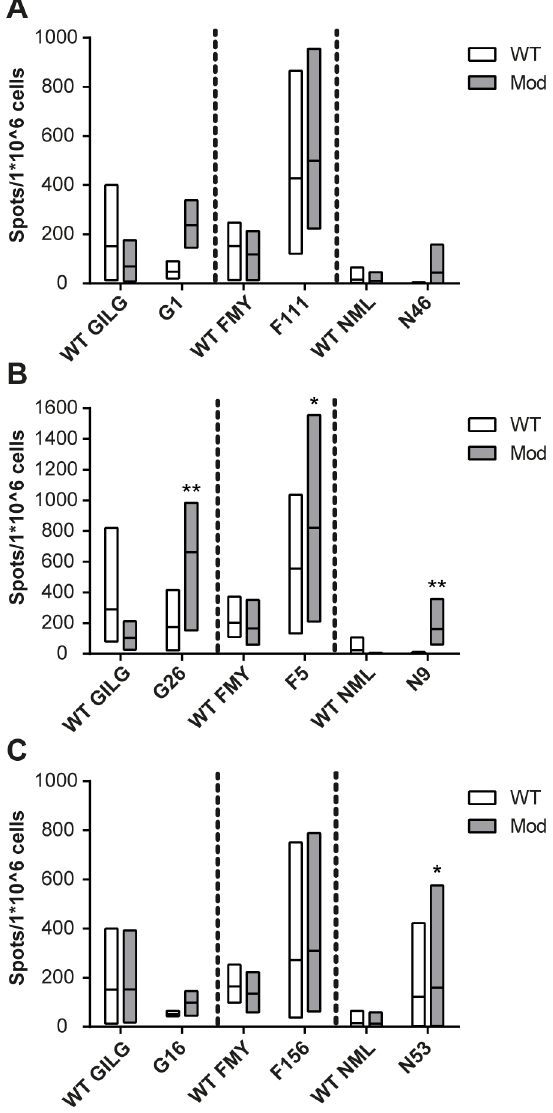
Fig 5. Predictive value of modifications. IFN- γ ELISpot on spleen cells of mice vaccinated with 75 nmol of either WT peptide or CPLs and stimulated for 16 hours with 0.1 nmol WT peptide or CPL per well. The three different modifications are based on final selected peptides for each epitope: (A) am-phg on P 1 based on G1, (B) 4-FPHE on P 1 and 2-AOC on P 9 based on F5 and (C) NLE on P 2 based on N53. X-axis depicts peptide used for vaccination. White boxes represents restimulation with WT peptide and grey boxes restimulation with CPL. Bars are min to max, with line at mean. Although it appears difficult to predict whether a modification will work in a certain epitope, an effective modification in one epitope is in some cases also effective in other epitopes. Bars represent a minimum of three mice (GILGFVFTL and FMYSDFHFI) and a maximum of eight (NMLSTVLGV). Data were statistically analyzed using a Mann-Whitney test. * p < 0.05; ** p < 0.01 compared to the WT equivalent.